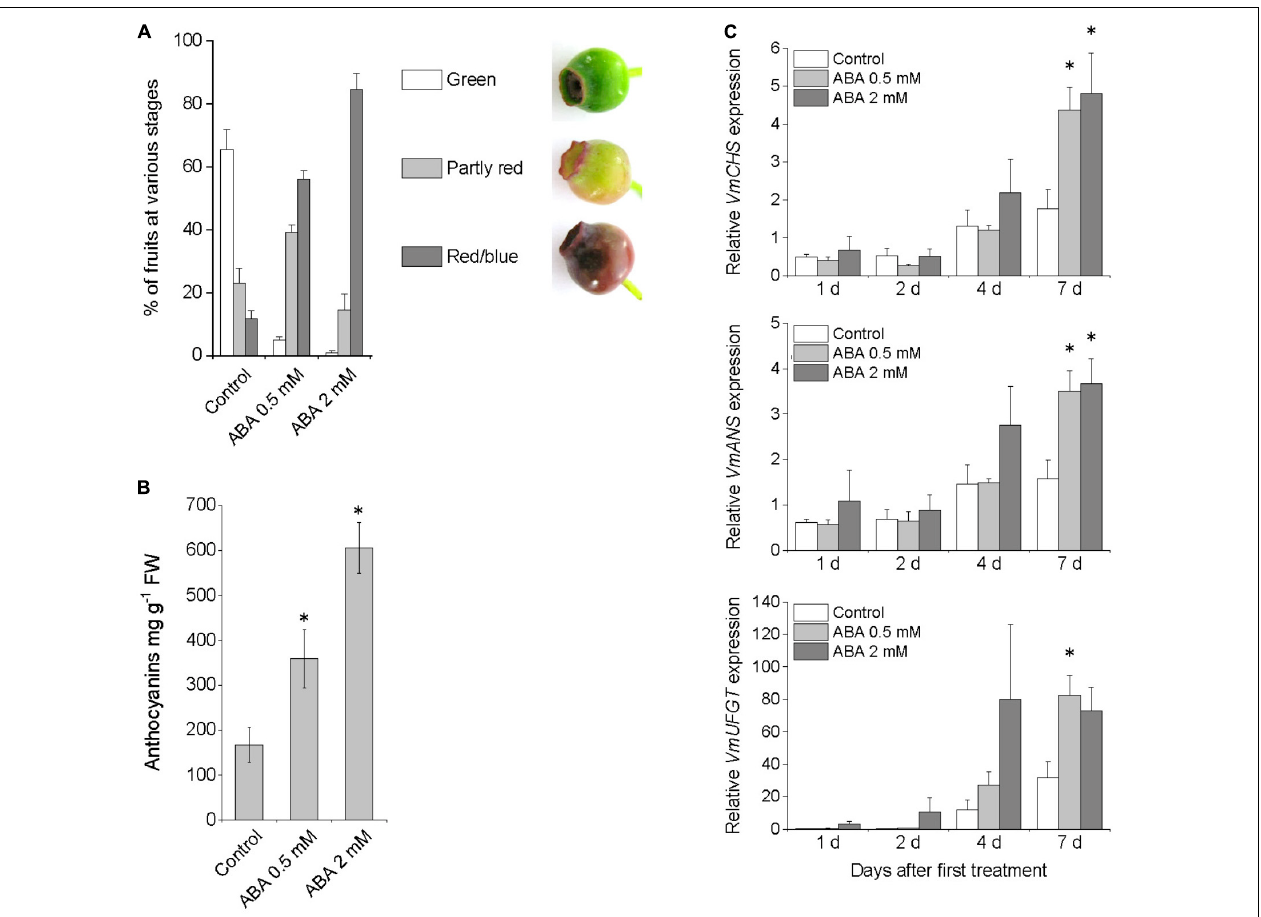
FIGURE 1 | Effect of pre-harvest treatment with ABA on bilberry fruit color (A) , anthocyanin content (B) , and expression of anthocyanin biosynthetic genes (C) . Unripe green berries attached to plants were sprayed with 0.5 mM ABA, 2 mM ABA or water (control). Fruit color and anthocyanin content was evaluated after 7 days from the beginning of the experiment. Total anthocyanin content is expressed as milligrams of cyanidin-3-glucoside equivalents g - 1 FW. Relative expression of the genes was quantified by qRT-PCR and normalized to VmGAPDH . Values represent means ± SEs of four replicates. Asterisks indicate significant differences from control in Student’s t -Test ( P ≤